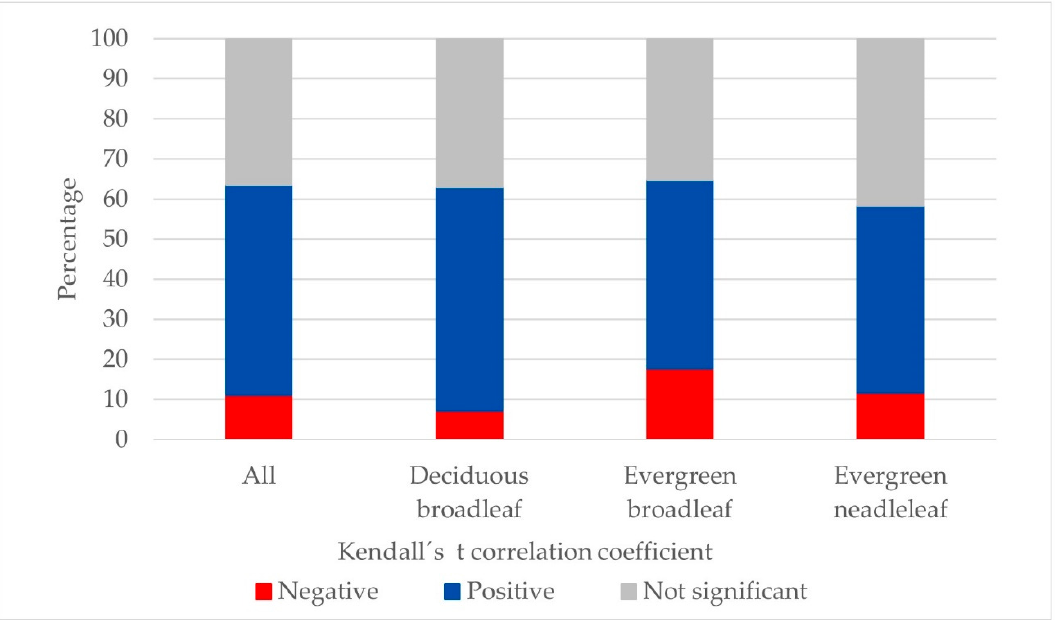
Figure 3. Direction of trends at 95% confidence level per forest type, 2002–2017.